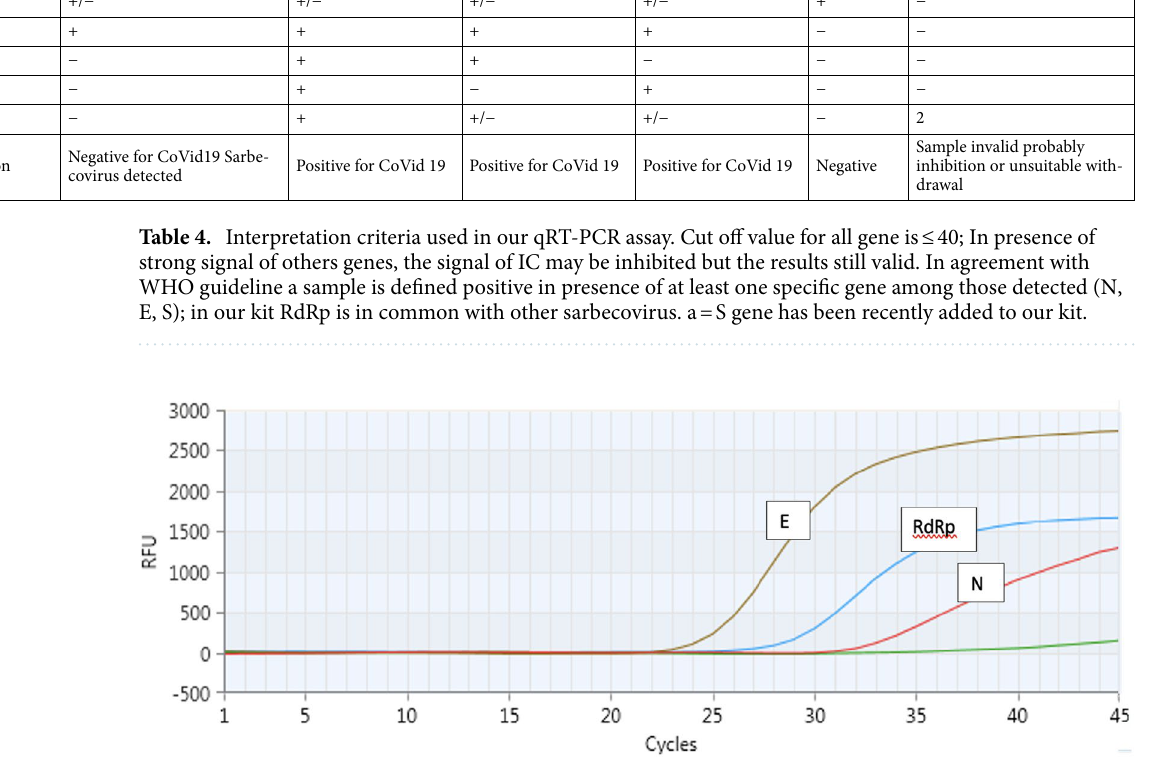
Figure 2. Figure illustrates the Real Time PCR curves of the genes detected by our kit; RdRp gene: RNA- dependent RNA polymerase gene; E: the envelope gene; N: the nucleocapsid gene of COVID-19. IC represents Internal Control (β-actin